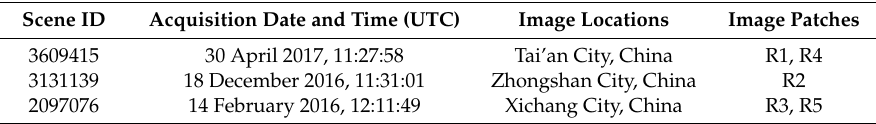
Table 2. The GaoFen2 satellite images used for the detection of buildings in this study.